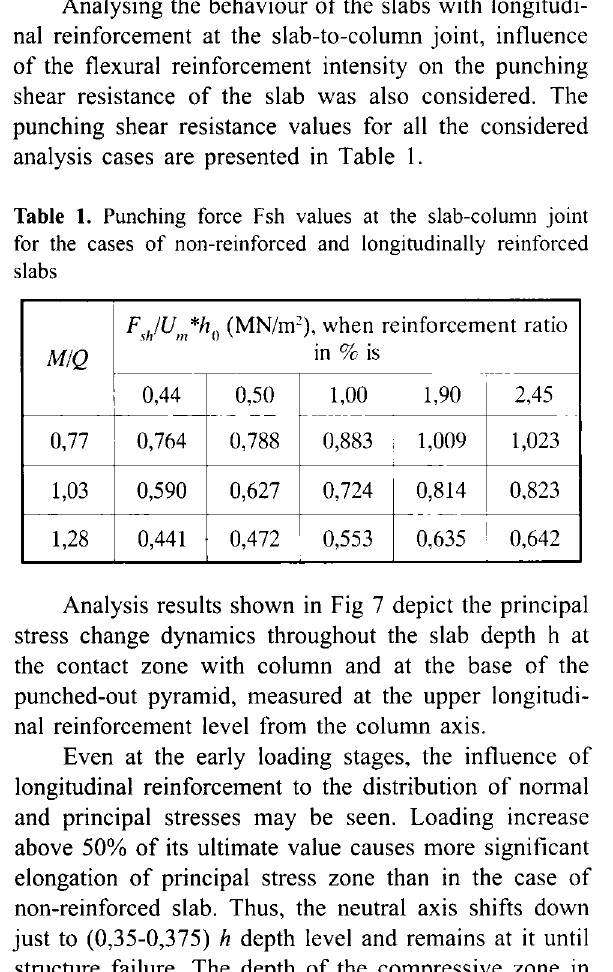
Fig 6. Normal crx (Sigma_X) and principal cr (Principal_!) stress distribution topology in the slab-col umn joint at the failure stage one may see that the edge of the base of punched-out pyramid is at the distance h, ie, equal to slab depth, from the column side surface; this means that the incli nation angle of pyramid side planes is 45°. Having 6 m span, the mean value of this angle tends to increase from 40° for 160 mm slab depth up to 45°-47° for 200 mm slab depth, and even 55° for depth h=250 mm. Changing the span from 4,5 m to 6,0 or 7,5 m, the ratio of bending moment and shear force at the joint also changes, vary ing from M/Q=0,77 to 1,03 and 1,28, respectively. Some greater mean values of this angle (52°) observed in cases of small spans, and similar results (45°-50°) were ob tained for 6,0 and 7,5 m slab spans.